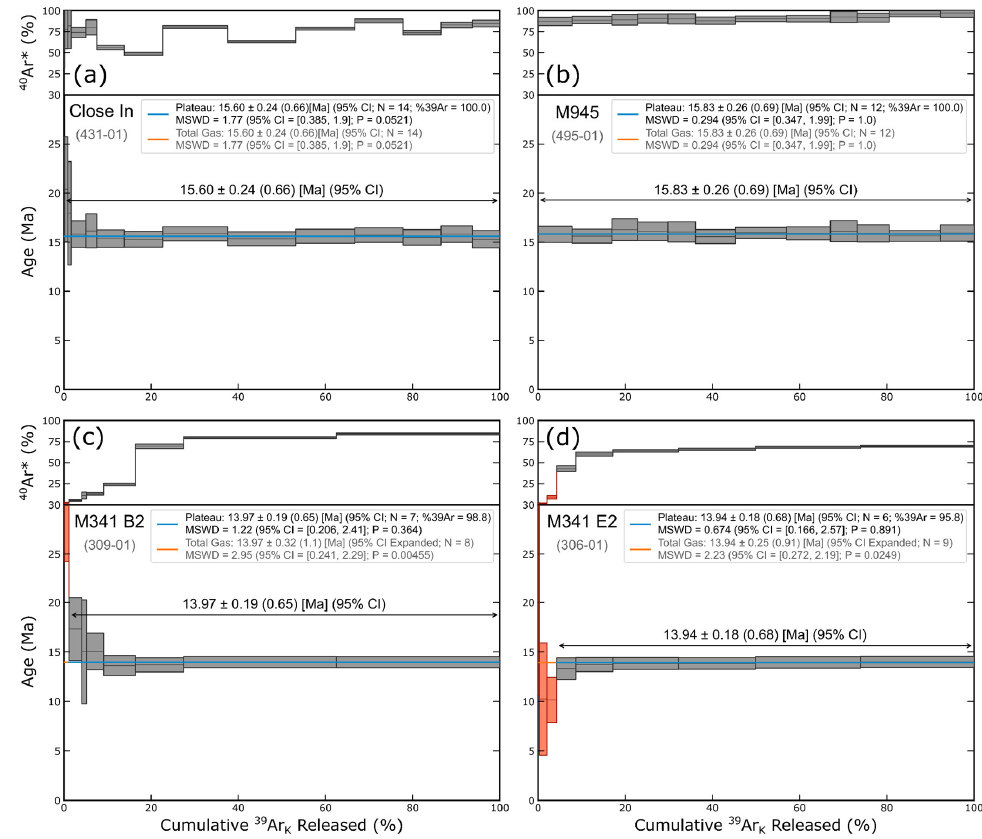
Figure 4. Selected 40 Ar/ 39 Ar release spectra for samples of magmatic-steam alunite. ( a , b ) Results for Close In and M945 representing an older pulse of hydrothermal activity ca. 15.7 Ma. ( c , d ) Results for M341 bands B2 and E2 representing a younger pulse of hydrothermal activity ca. 14 Ma. Red steps were excluded from plateau calculations, while both gray and red steps were included when computing total gas dates. External age uncertainties are shown in parentheses after internal uncertainties. The 95% CI of the asymmetric 𝑀𝑆𝑊𝐷 are shown in square brackets in the inset legends; where the value of the 𝑀𝑆𝑊𝐷 falls outside of these bounds, the resulting uncertainties were expanded by √𝑀𝑆𝑊𝐷 (this only affected the total gas dates for M341 B2 and E2).